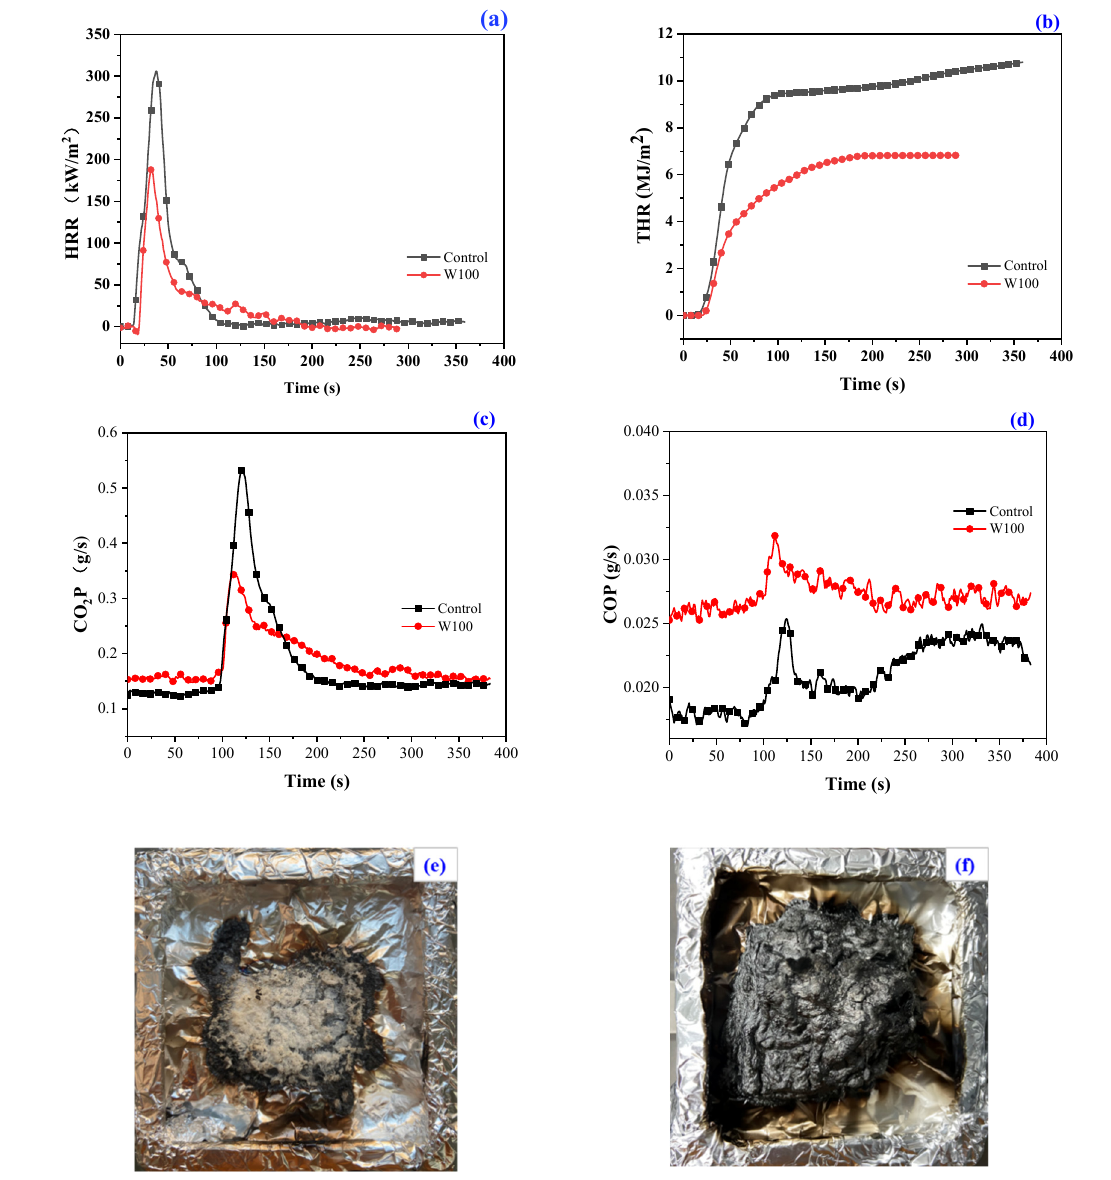
Figure 4. The HRR ( a ), THR ( b ), CO 2 P ( c ), and COP ( d ) curves of the control wool and the wool treated with PBTCA. Photos